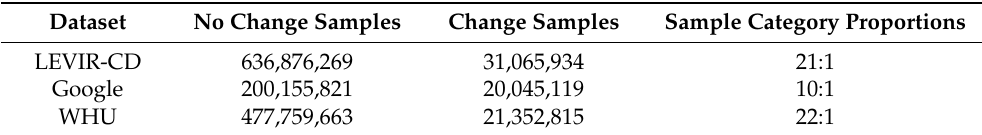
Table 1. Initial data distribution of building change detection